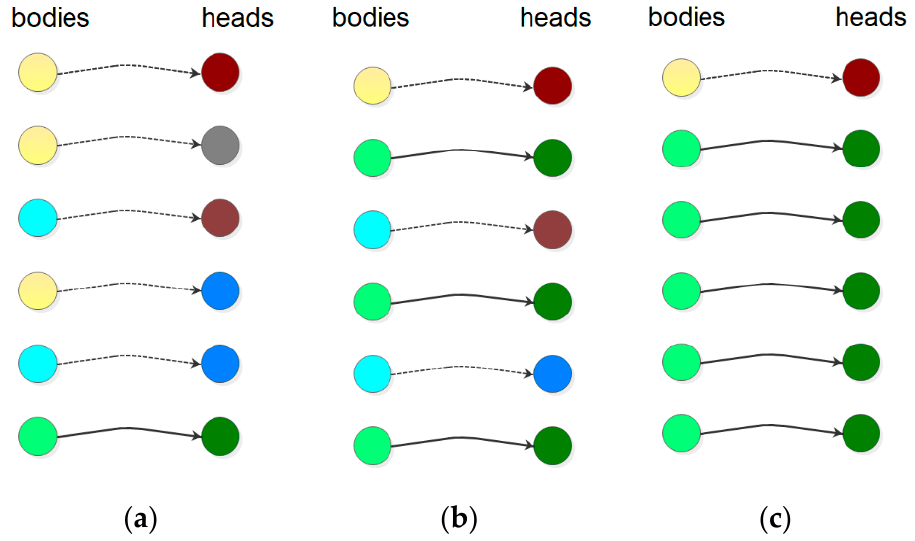
Figure 3. Three different exemplary datasets ( a – c ) with the rules of the same confidence of 100%. The rule: if light green, then dark green.